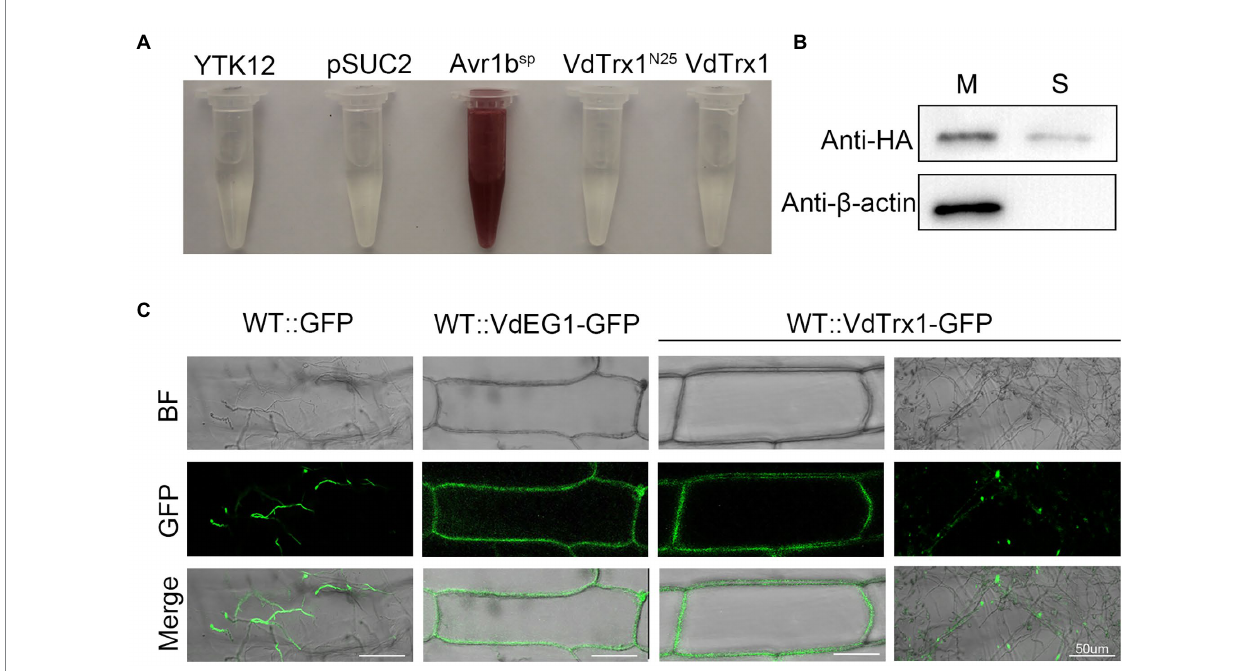
FIGURE 3 VdTrx1 can be secreted by V. dahliae to extracellular spaces. (A) Validation of the non-secretory function of the 25 aa N -terminal peptide and full- length sequence of VdTrx1 by a yeast signal trap assay. The region encoding the 25 aa N -terminal peptide and the full-length sequence of VdTrx1 were fused in-frame to the invertase sequence in the pSUC2 vector and transformed into yeast strain YTK12. The untransformed YTK12 strain and empty pSUC2 vector transformed into YTK12 were used as negative controls, while the pSUC2-Avr1b SP vector (integrating known functional signal peptide Avr1b SP into pSUC2) transformed YTK12 was used as a positive control. Only yeast strains that can secrete invertase converted 2,3,5- triphenyl tetrazolium chloride (TTC) to red triphenylformazan. (B) Western blotting assay demonstrates VdTrx1 secretion into culture filtrates. VdTrx1-HA was expressed in V. dahliae wild-type strain Vd991 to produce strain WT::VdTrx1-HA. Proteins extracted from mycelia (M) and culture supernatants (S) of strain WT::VdTrx1-HA were analyzed using western blotting with anti-HA or anti- β -actin antibodies, as indicated. (C) Live-cell imaging by confocal microscopy of VdTrx1. V. dahliae strains WT::VdTrx1-GFP, WT::GFP and WT::VdEG1-GFP were used to infect onion epidermal cells (the latter two strains were used as controls), respectively. Images were taken at 5 dpi using confocal laser scanning microscopy to perform a subcellular localization assay. Bar, 50 μ